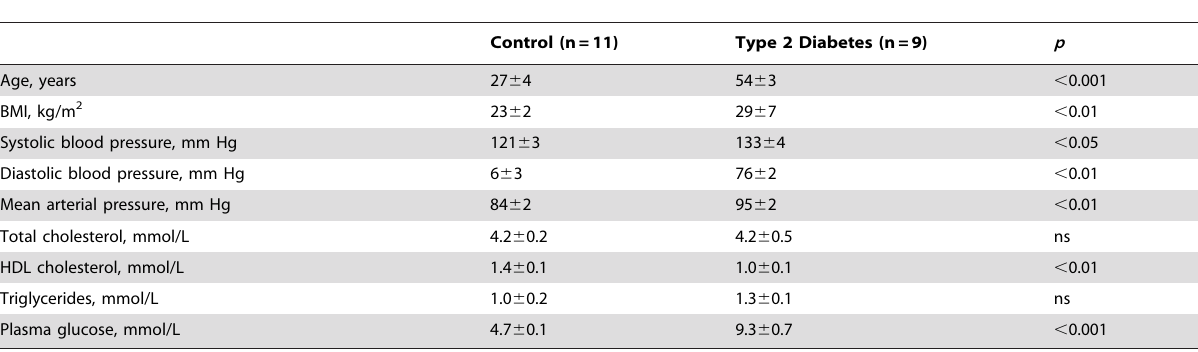
Table 1. Clinical characteristics of the study cohort.